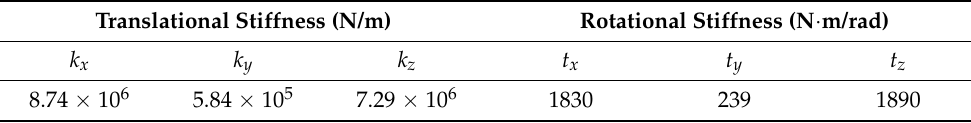
Table 6. Stiffness parameters of the P-type clamp